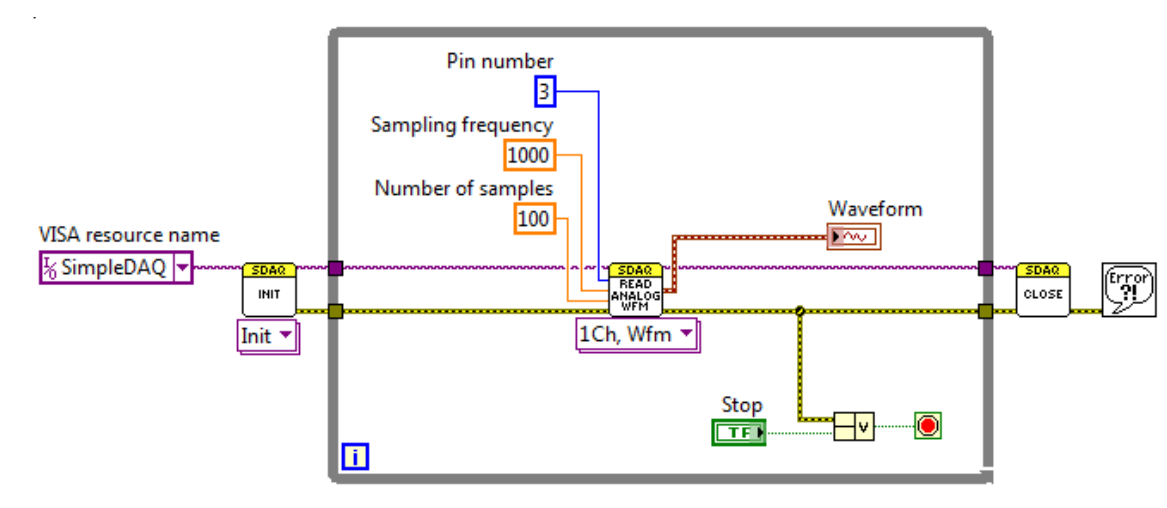
Figure 12. Acquisition of waveform using a hardware